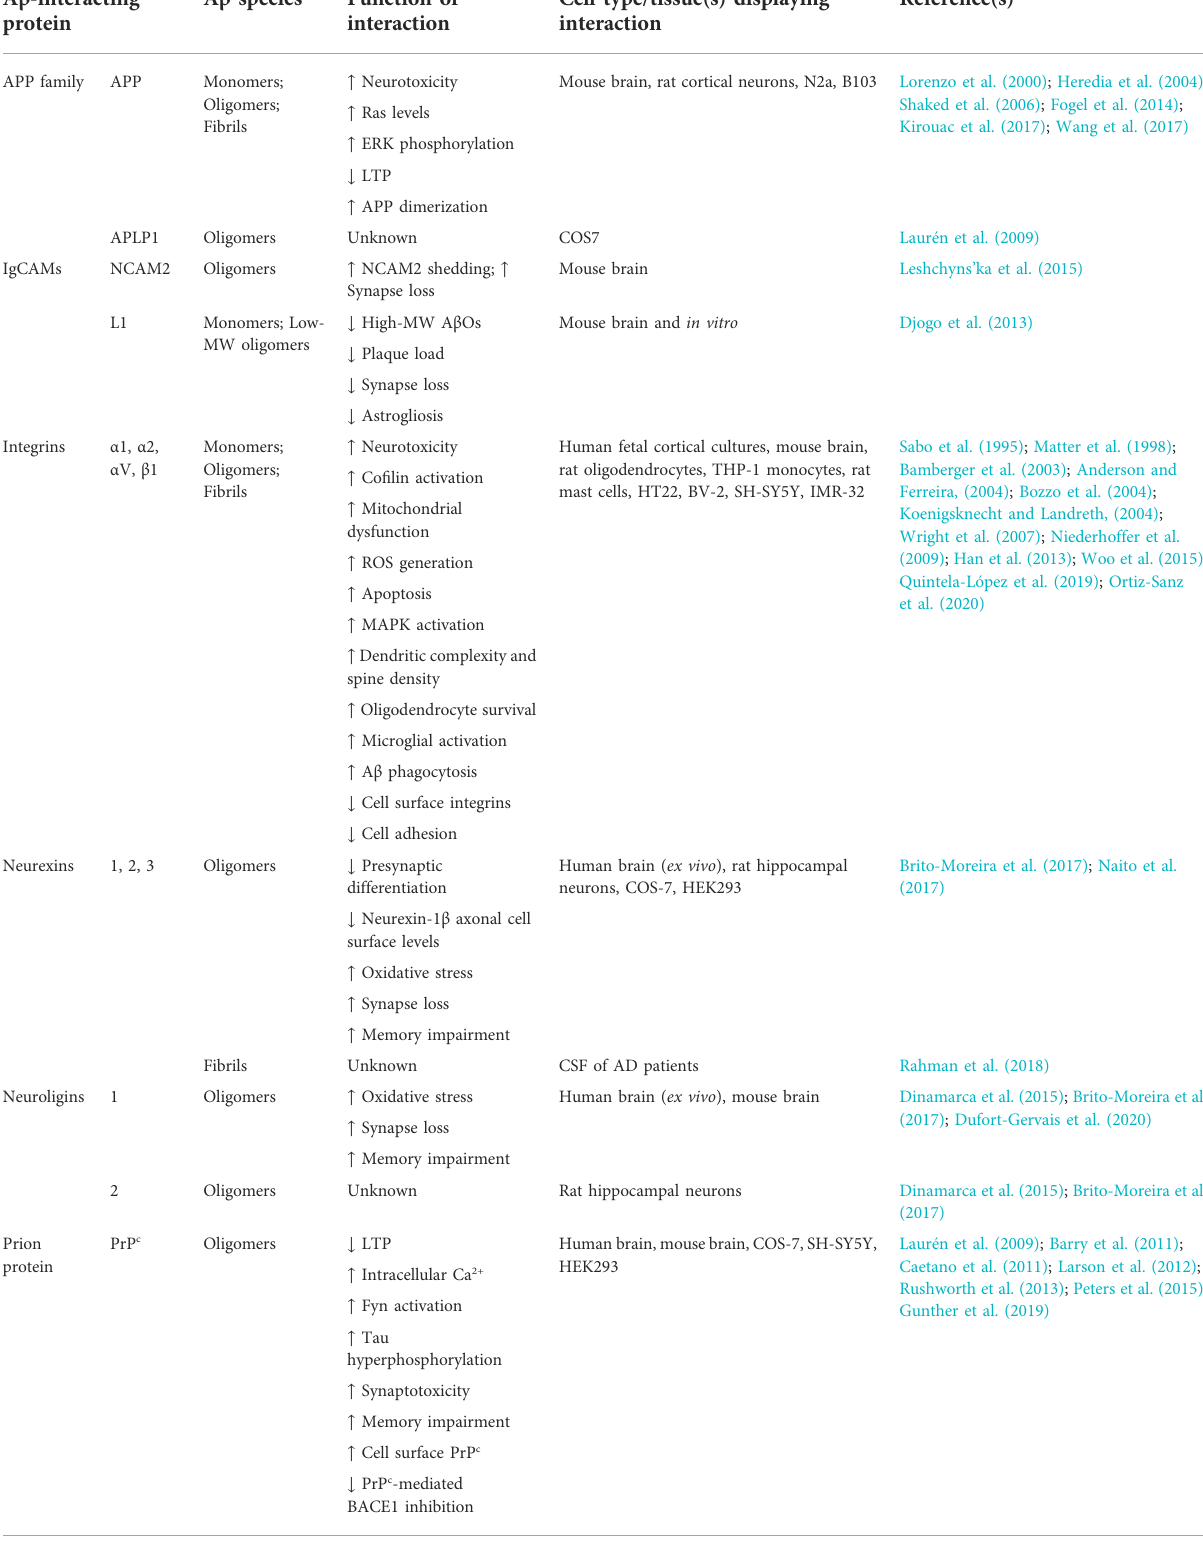
TABLE 2 A β -interacting cell adhesion molecules and their role in A β